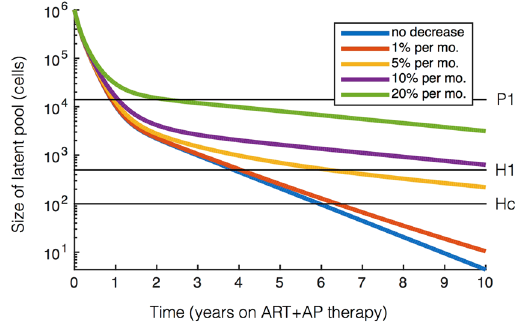
Figure 5. Waning anti-proliferative potency over-time modulates cure. Latent reservoir dynamics on combined ART and anti-proliferative therapy simulated for waning potency of anti-proliferative therapy over time. The latent reservoir size is shown with horizontal black lines corresponding to the cure threshholds used throughout the paper. Cure thresholds are achieved within 10 years if potency decreases by less than 5% per month considering 1% naïve T cells ( L n (0)/ L 0 = 0.01) and initial anti-proliferative potency ε AP = 5.